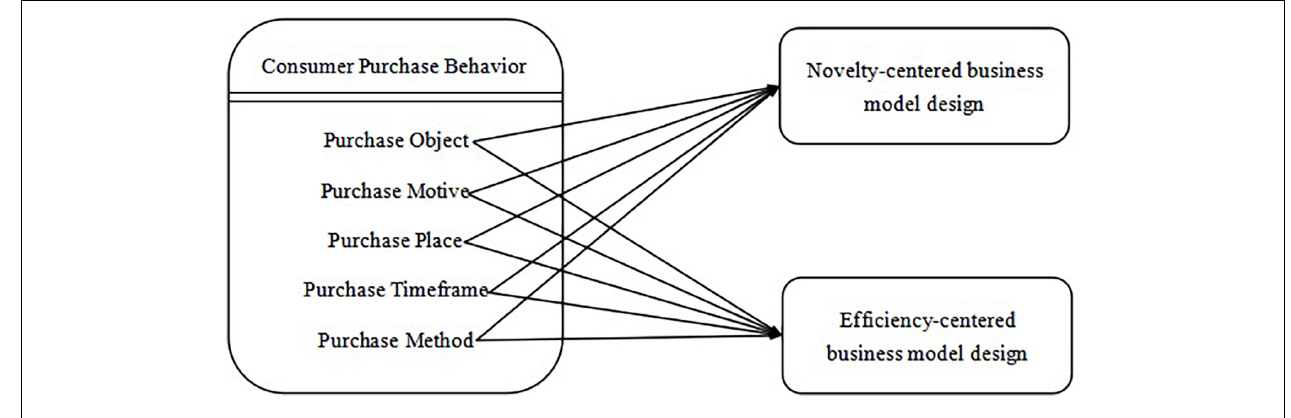
FIGURE 1 | Conceptual